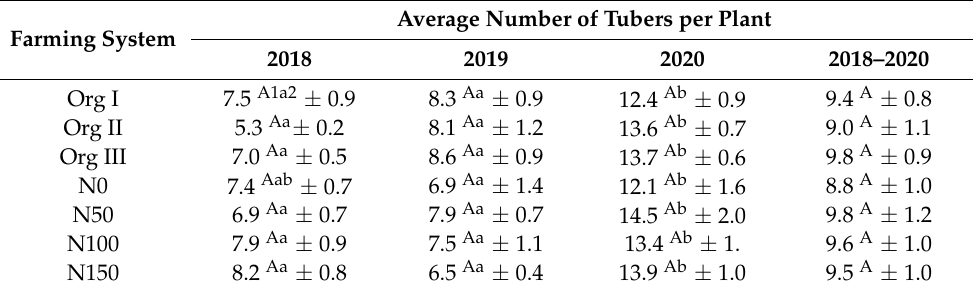
Table 6. Average number of tubers per plant depending on the farming system. Farming